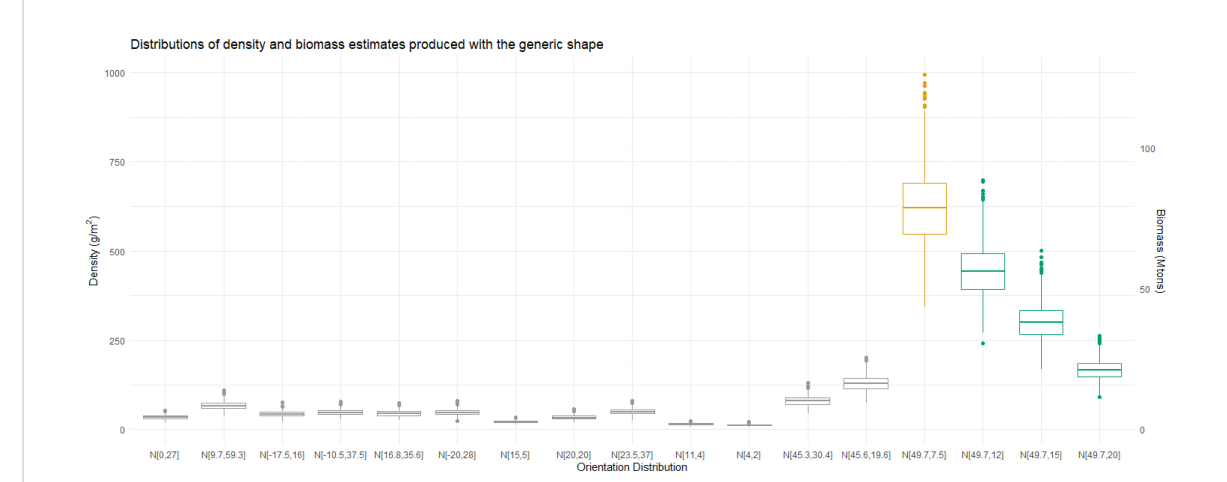
FIGURE 14 Boxplots of 999 density and biomass estimates for a range of orientation distributions. The midline of the boxplot represents the median estimates. The fi rst fourteen orientation distributions are literature values. Computing the estimates with N [49.7°,7.5°]results in much higher values than for any of the other reported distributions, highlighted in orange. Three additional orientation distributions, highlighted in green, illustrate how increasing the standard deviation of N [49.7°,7.5°] to 12°, 15°, and 20° reduces the